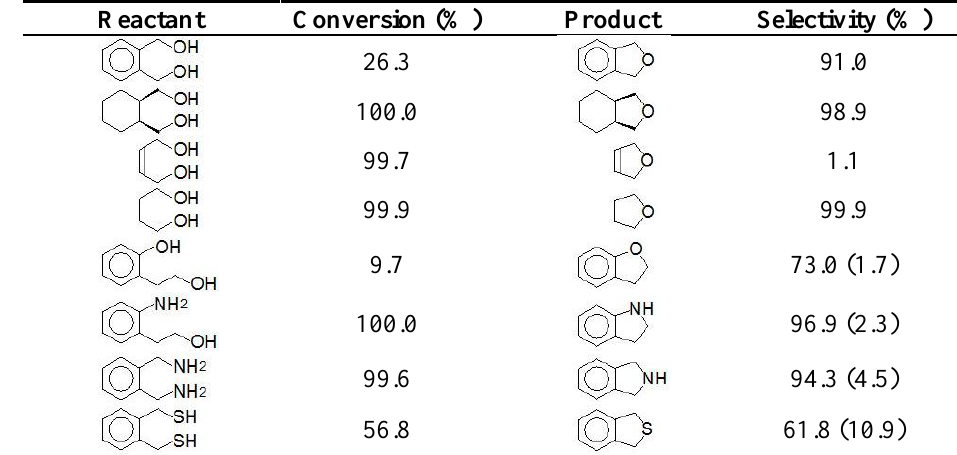
Cl )Cl (H O) ]·4H O/SiO 6 12 2 2 4 2